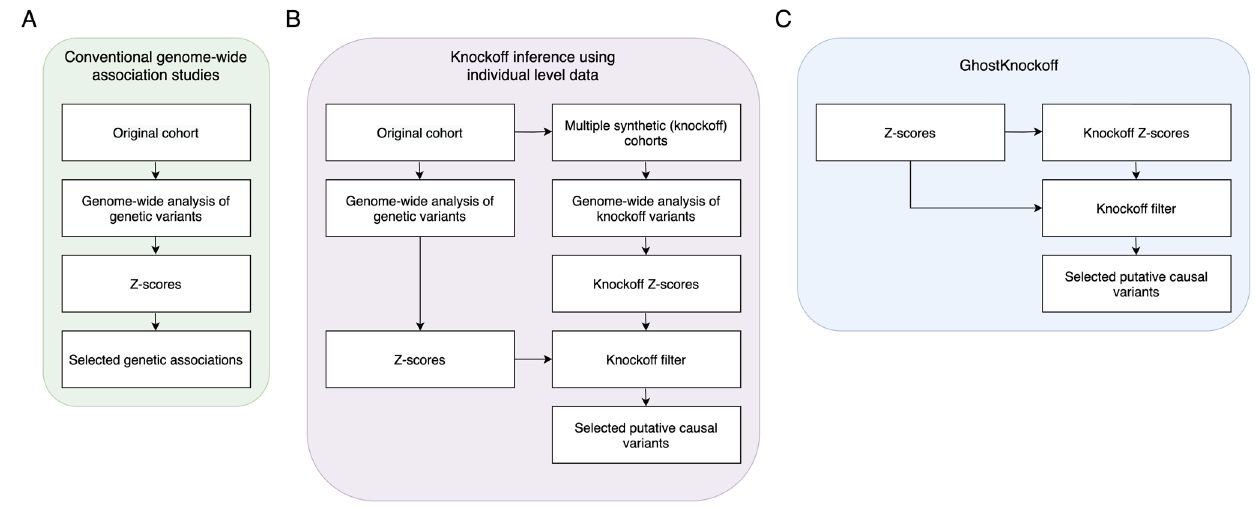
Fig. 1 | Overview of GhostKnockoff. We present the work fl ow of GhostKnockoff compared to conventional GWAS and knockoff inference based on same marginal test statistics using individual level data. A Conventional GWAS. B Knockoff